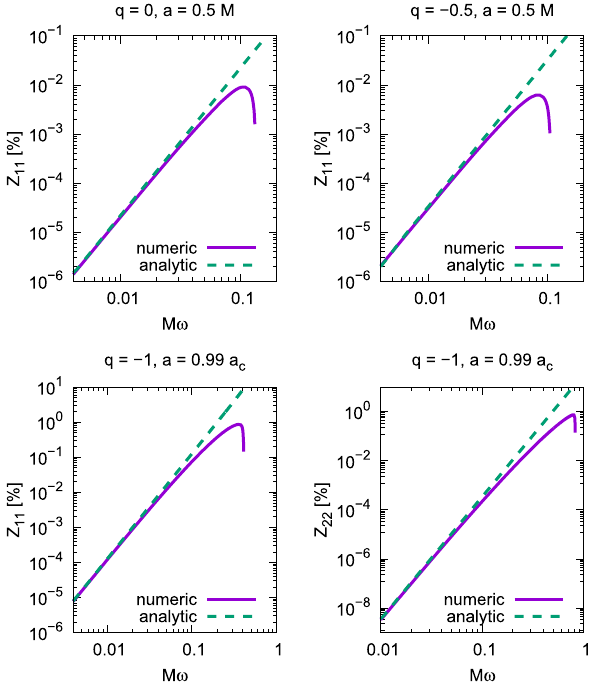
Fig. 3 A sample of comparisons between the numeric and analytic results obtained in the low-frequency regime. Similar agreement has been found for other choices of the set ( q , a